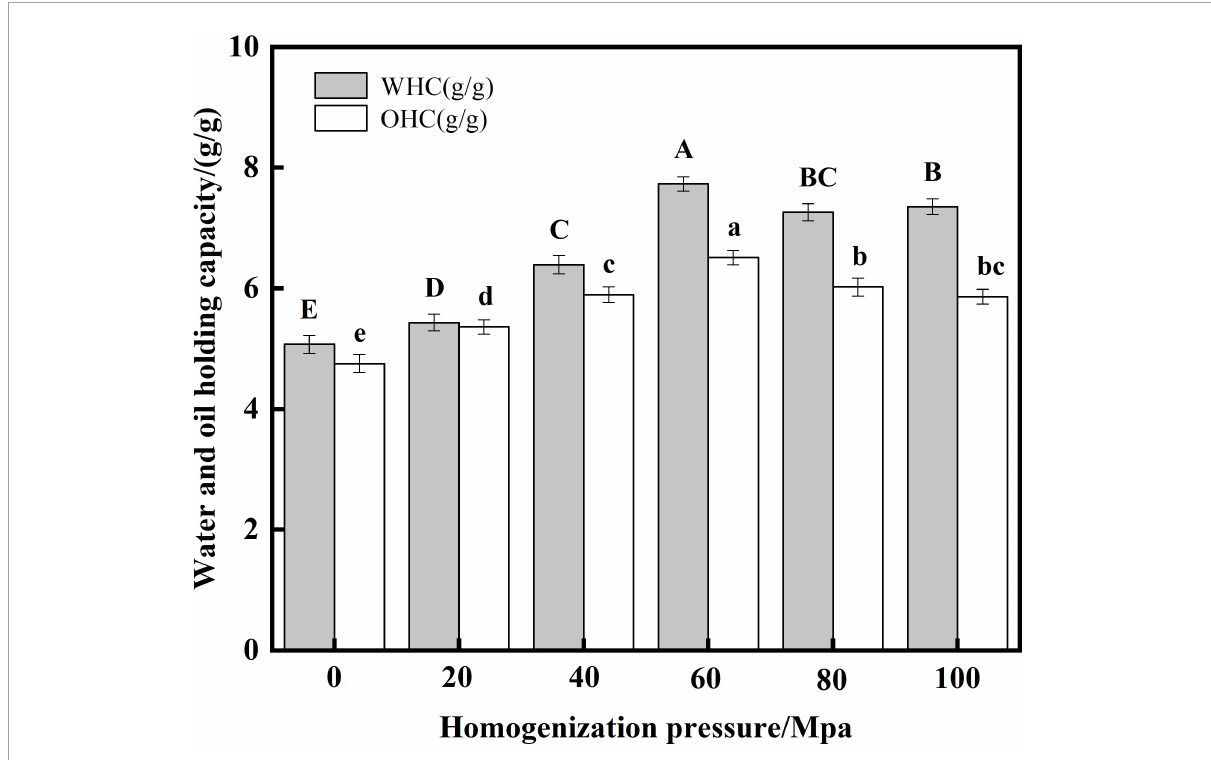
FIGURE7 Effects of high-pressure homogenization (HPH) on the water and oil capacity of enzymatic hydrolyzed soybean protein concentrate